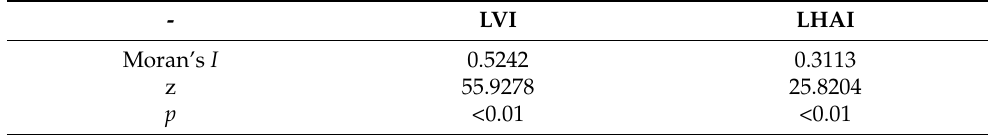
Table 6. Global Moran’s I